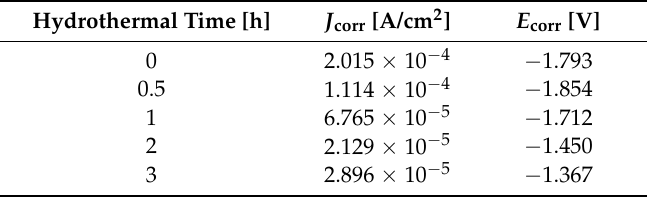
Table 2. J corr and E corr of the samples HT0.5, HT1, HT2 and